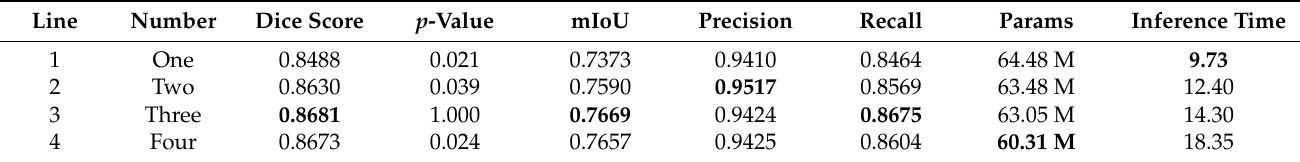
Table 1. “Number” in the table meant the number of ADA modules. All p -values in this table were obtained by comparing with line 3. Place ADA module from the lowest layer of the model. For example, “one” meant an ADA module was applied on the last layer, and “two” meant that an ADA module was placed on the last and penultimate layers. The best performance was shown in bold.